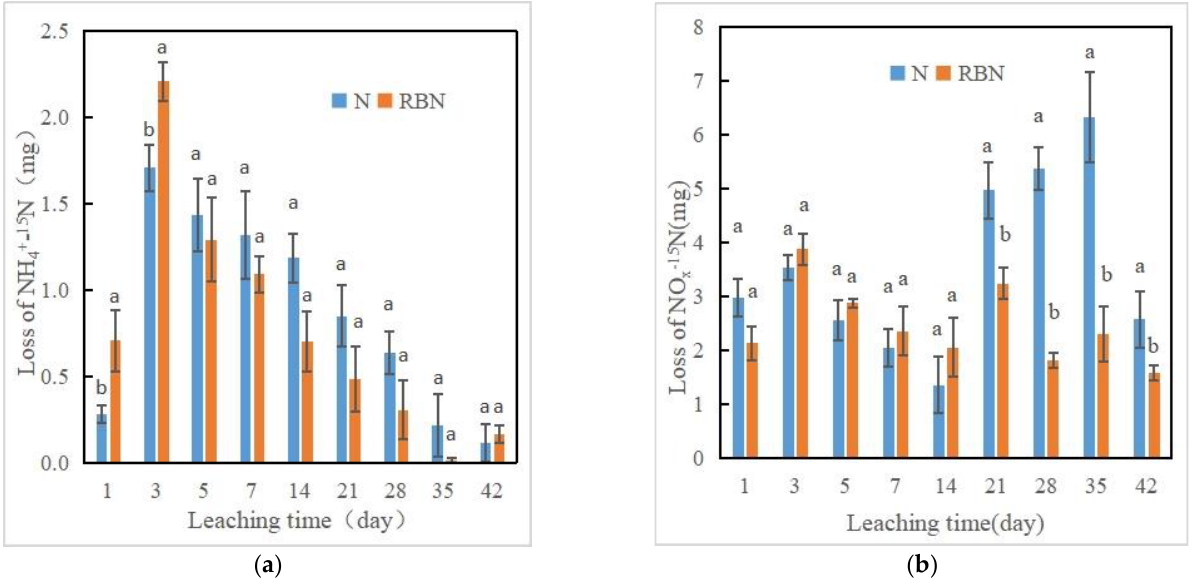
Figure 7. ( a ) Loss of NH 4+ - 15 N; ( b ) loss of NO x − - 15 N. Different letters in the image indicate significant differences between treatments (p < 0.05).